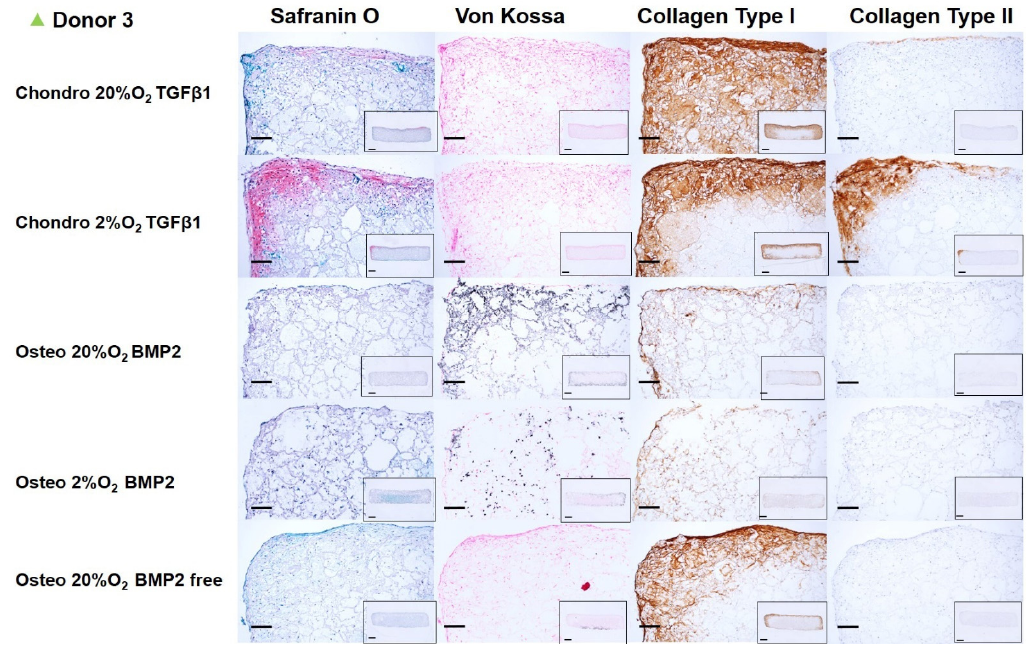
Figure 8. Chondrogenic and osteogenic hBMSC-constructs after 2 weeks of culture. Images showing a higher magnification of donor 3. Scale bar: 200 μ m. Inset: Images showing the full section of the constructs 1. Scale bar: 1 mm. Scaffolds were stained with safranin O/Fast Green, Von Kossa and immunohistochemically labelled for collagen type I and collagen type II. Chondrogenically differentiated groups showed higher Safranin O, Collagen Type I and Collagen type II deposition. The osteogenically differentiated groups with BMP2 are positive for Von Kossa staining.